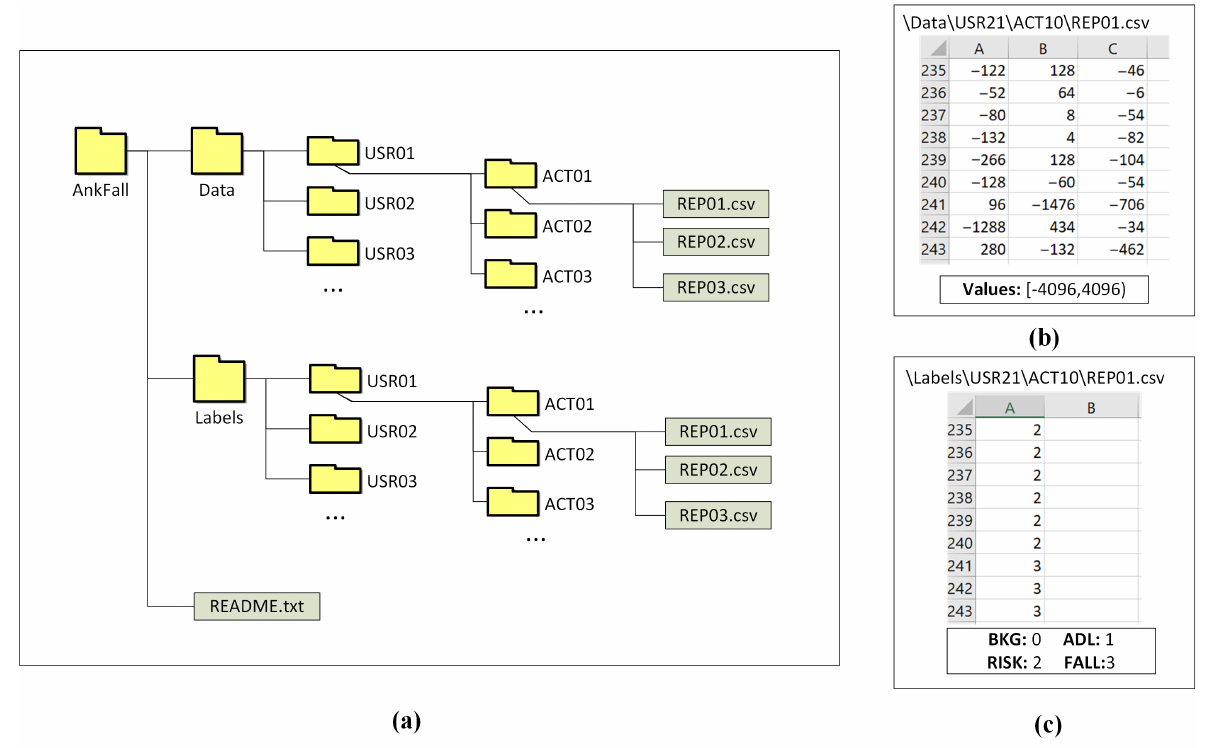
Figure 7. AnkFall internal structure: ( a ) Folder structure; ( b ) Data collected from user 21 during activity 10, repetition 1; ( c ) Labels for each sample of data collected during activity “( b